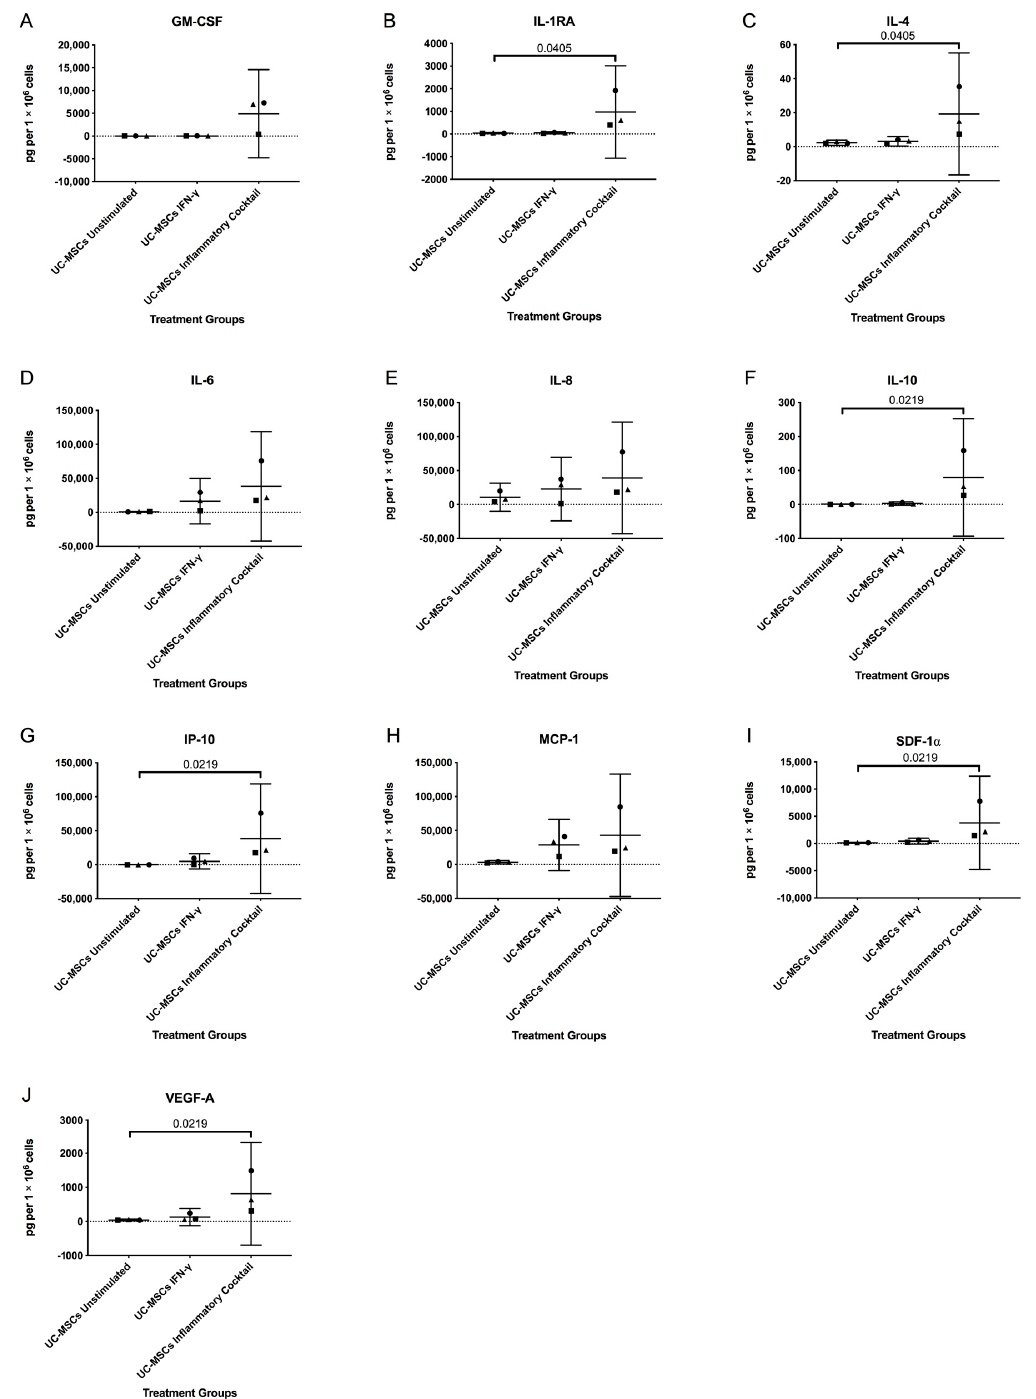
Figure A2. Levels of inflammatory markers measured in conditioned media collected from the following human UC-MSC cell cultures: un-stimulated, stimulated with IFN- γ (25 ng/mL for 24 h) and stimulated with an inflammatory cocktail (25 ng/mL IFN- γ , 50 ng/mL TNF- α 10 ng/mL IL-1 β for 24 h) and assessed for the presence of several analytes to determine the in vitro response of the human UC-MSCs to an inflammatory environment which were applied to the injured mice knees. Stimulation with IFN- γ alone for 24 h made no significant difference from the unstimulated hUC-MSCs for any of the analytes assessed ( A – J ). However, IL-1RA ( B ), IL-4 ( C ), IL-10 ( F ), IP-10 ( G ), SDF-1 α ( I ) and VEGF-A ( J ) were significantly increased following stimulation with an inflammatory cocktail for 24 h, compared with the unstimulated human UC-MSCs; no significant differences were observed for GM-CSF ( A ), IL-6 ( D ), IL-8 ( E ) or MCP-1 ( H ). Data are presented as the ± 95% CI. Significance was determined below p < 0.05. (cid:4) = donor D1; (cid:78) = donor D2; • = donor